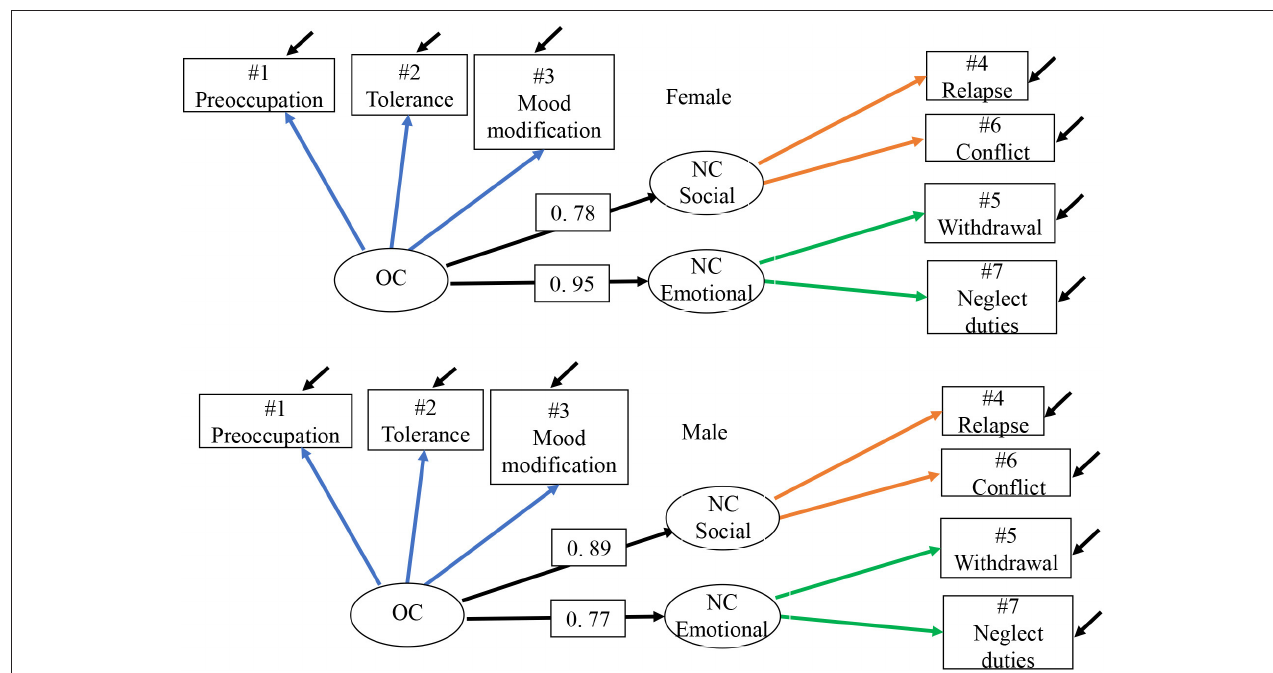
FIGURE 3 | Model 3.1 gm—GASA MGCFA 3 by gender, metric. Two-group three-factor model by gender with core items divided into NC social and emotional with equality constraints across gender groups for corresponding measurement models. Residual correlations NC social with NC emotional (not represenated in the path diagram) for males is 0.40 and for females 0.87. OC, over consumption; NC, negative consequences.